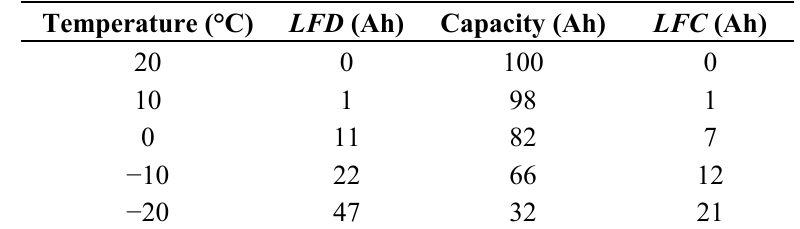
Table 2. LFD , LFC , and available capacity at different temperatures with respect to the 20 °C 1/3C rate.